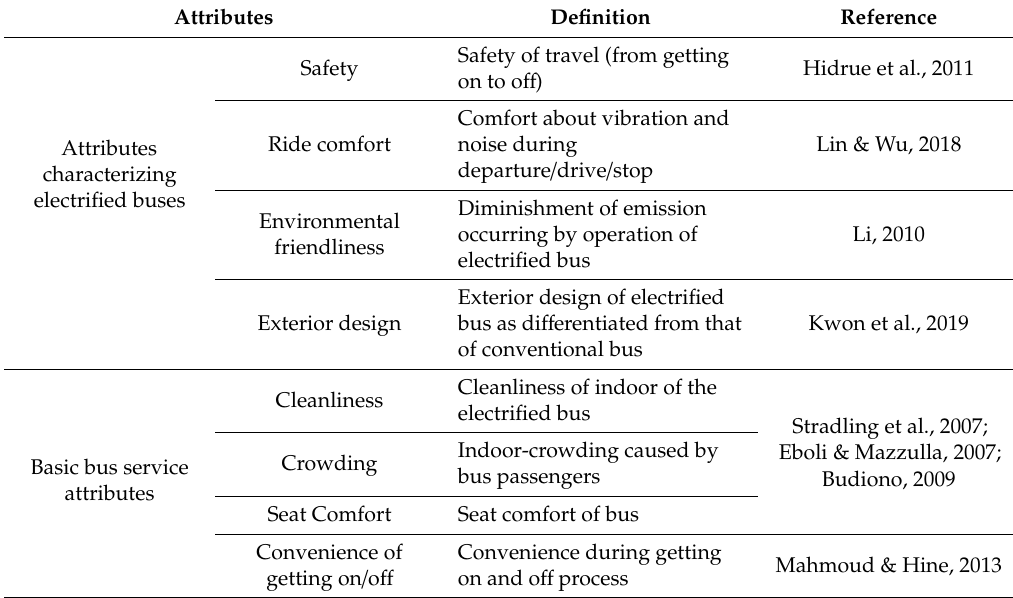
Table 1. Definitions of electrified bus